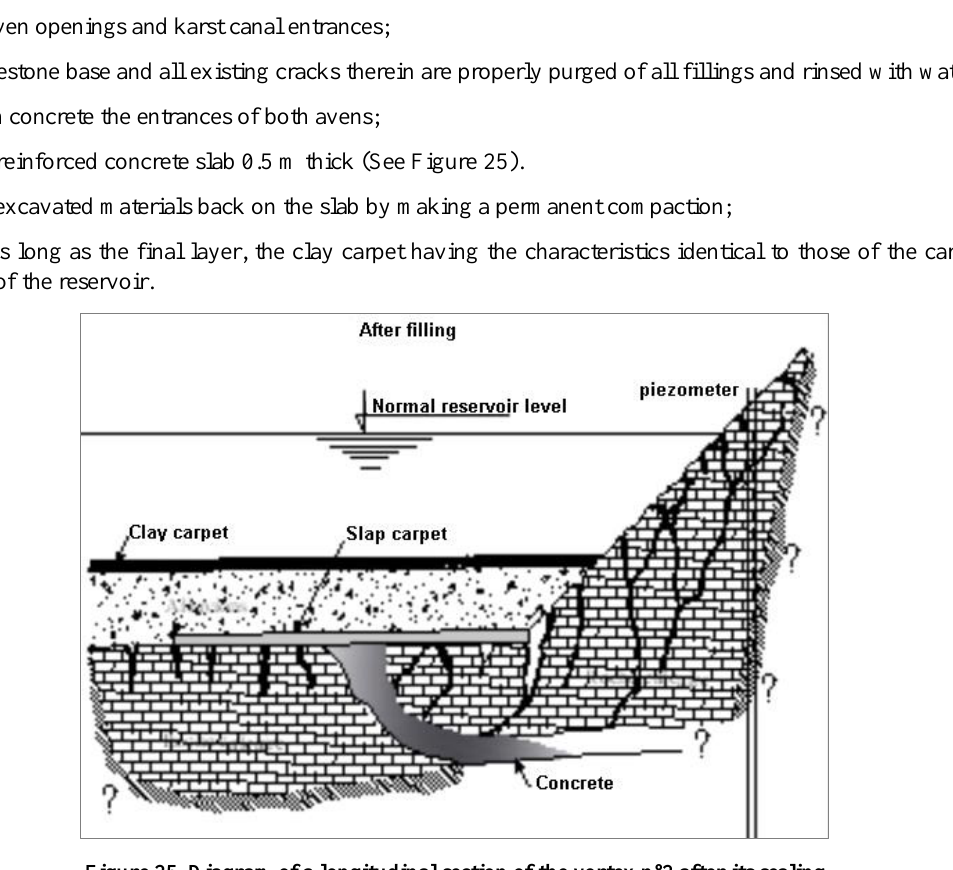
Figure 25. Diagram of a longitudinal section of the vortex n°2 after its